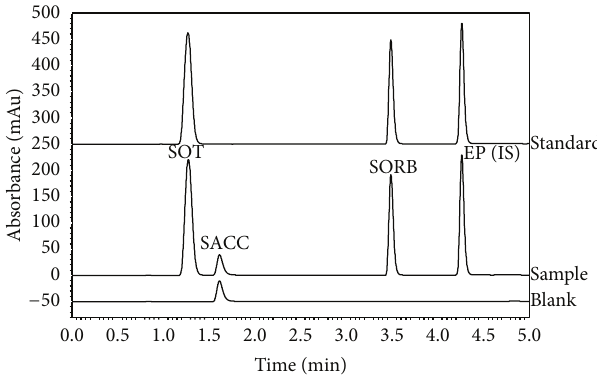
Figure 2: Chromatograms of the standard solution (SOT 0.2 mg mL −1 , SORB 0.04 mg mL −1 , and EP 0.08 mg mL −1 ), sample solution (1.000mL of pharmaceutical preparation and 1.000 mL of stock solution of internal standard EP diluted to 25.00 mL), and blank solution (1.000 mL of placebo diluted to 25.00 mL); injection volume 5 𝜇 L; mobile phase flow 1.3 mLmin −1 ; linear gradient (ACN: 10% to 60% in 4 minutes); UV/Vis detector wavelength 237 nm; column oven 25 ∘